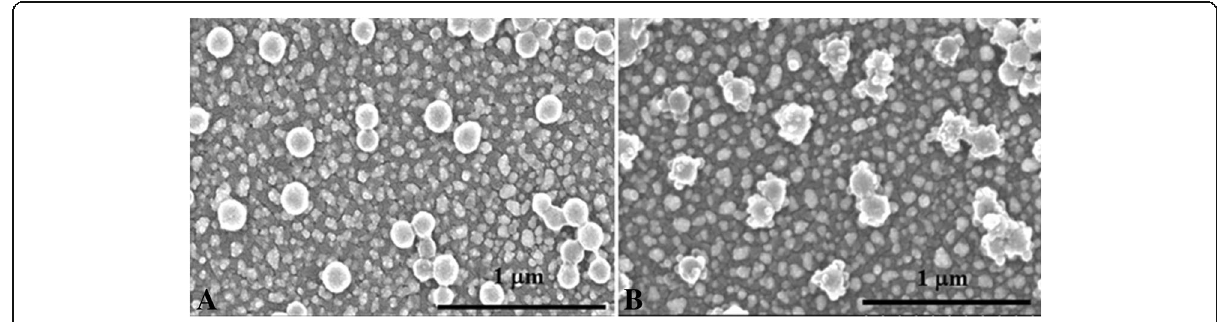
Fig. 1 SEM images of Pd-CNCs/peptides/Au-rGO/GCE ( a ) treated with catalytic precipitation reaction ( b